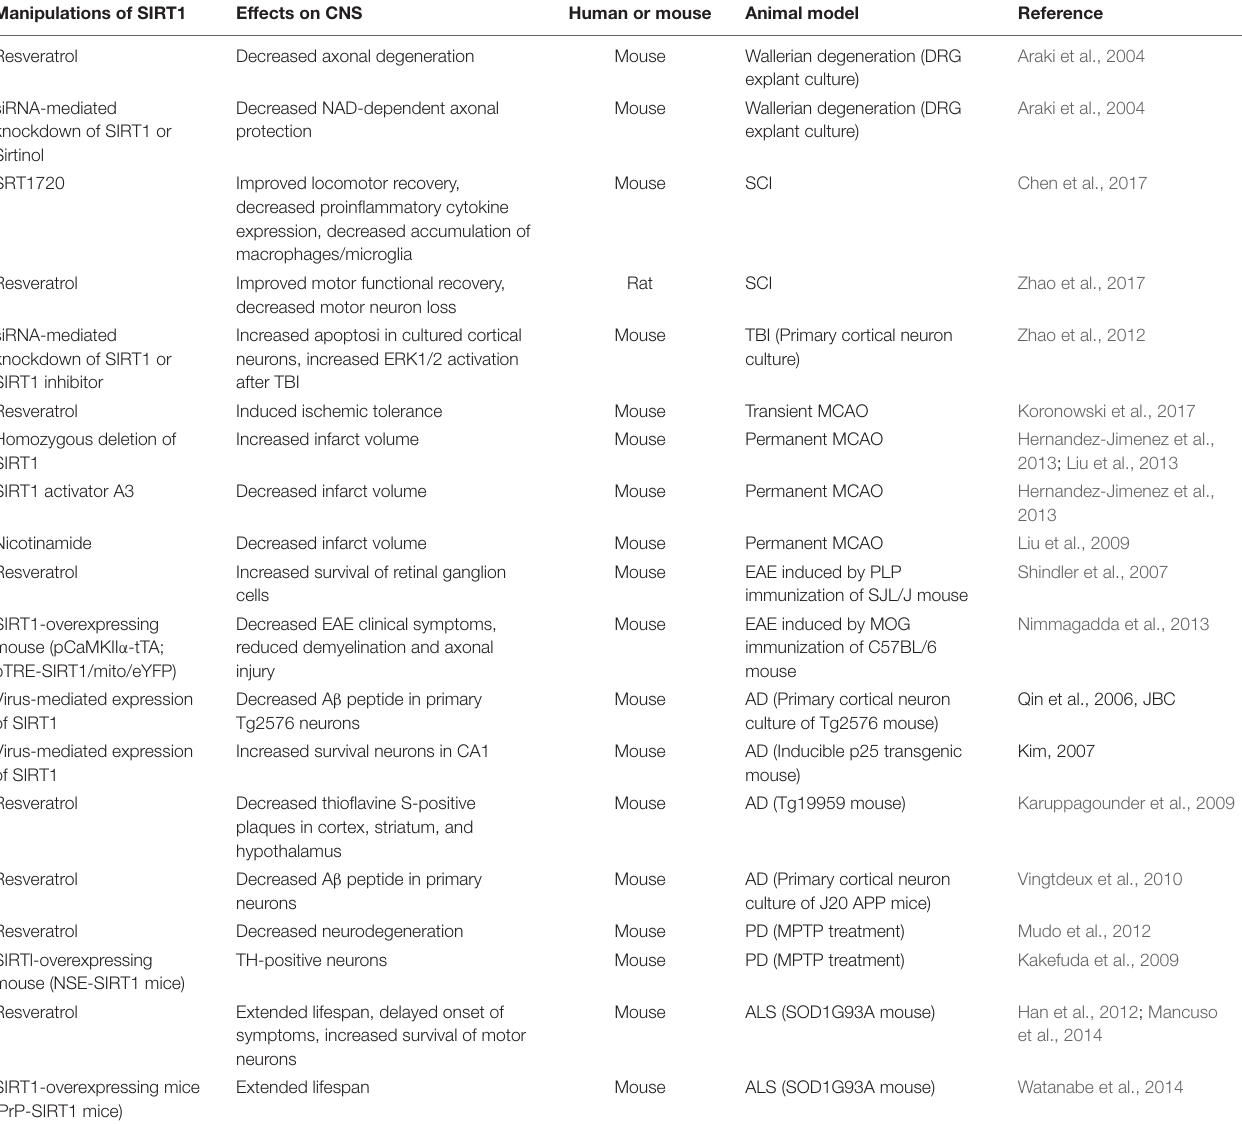
TABLE 3 | The role of SIRT1 in animal models of neurodegenerative diseases. Manipulations of